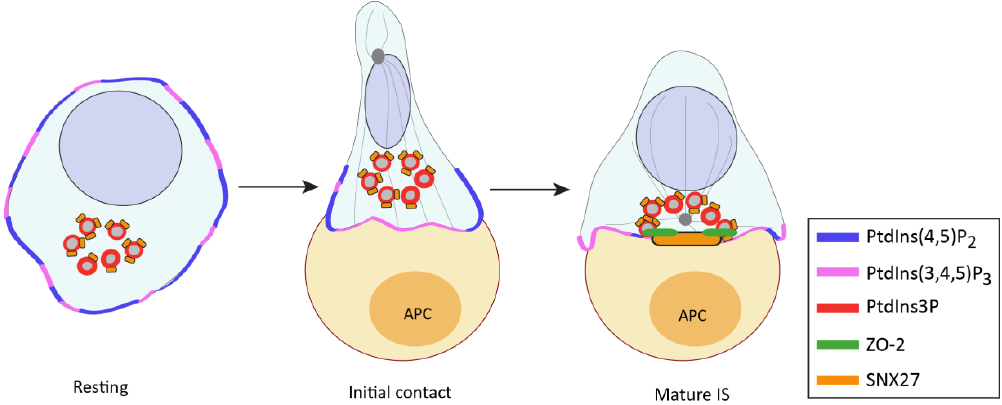
Figure 3. SNX27 is recruited to the IS and facilitates trafficking of cargoes toward this structure. In resting T cells, SNX27 is mainly found at PtdIns(3)P-positive endosomes. Upon T-cell activation, these endosomes polarize toward the cell–cell interface, and a fraction of this protein accumulates at the IS. This event is facilitated by the SNX27 PDZ domain and the interaction of its FERM domain with PtdIns(4,5)P 2 - and / or PtdIns(3,4,5)P 3 -enriched membrane regions. Binding of SNX27 to its cargoes can drive their mobility to the IS, as observed for zonula occludens-2 (ZO-2).